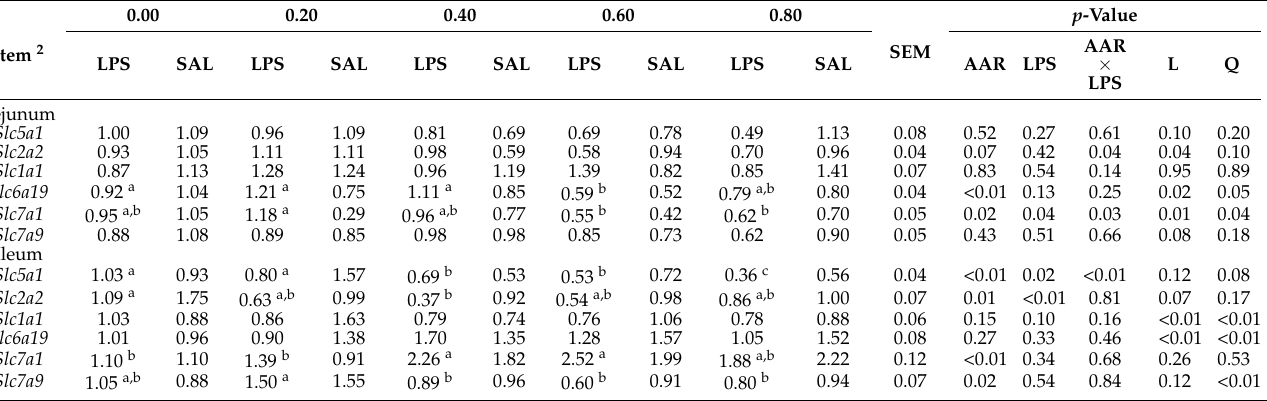
Table 5. Influence of diet with different amylose–amylopectin ratio and LPS challenge (intraperitoneal injection) on the nutrient transporters in jejunum and ileum of weaned piglets 1